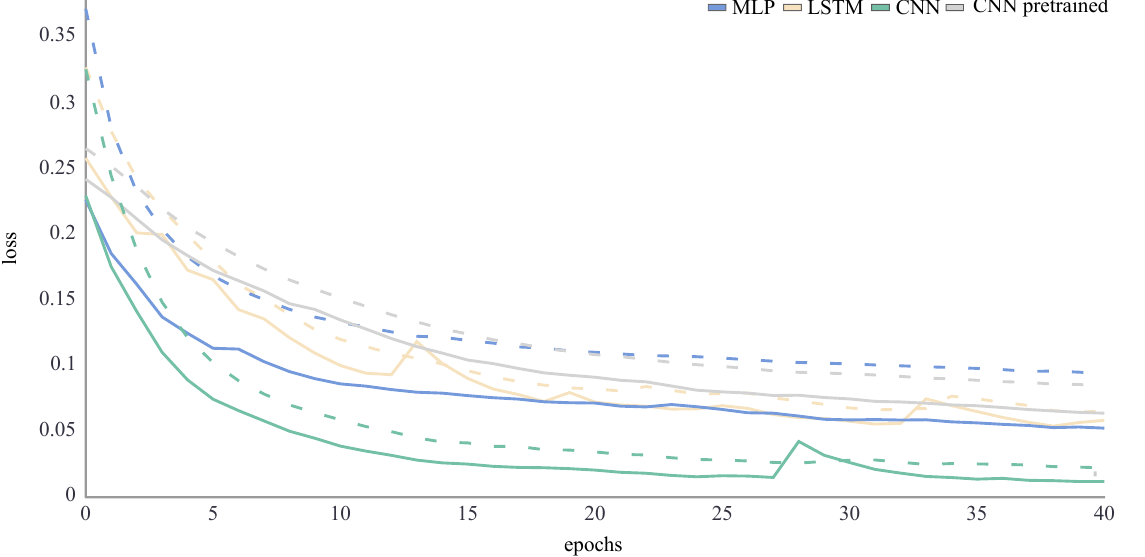
Figure 5. Loss curve of the joint moment training process of an exemplary LOSO validation for all ANNs. The training loss is displayed by a dashed line, while the validation loss is displayed by a solid